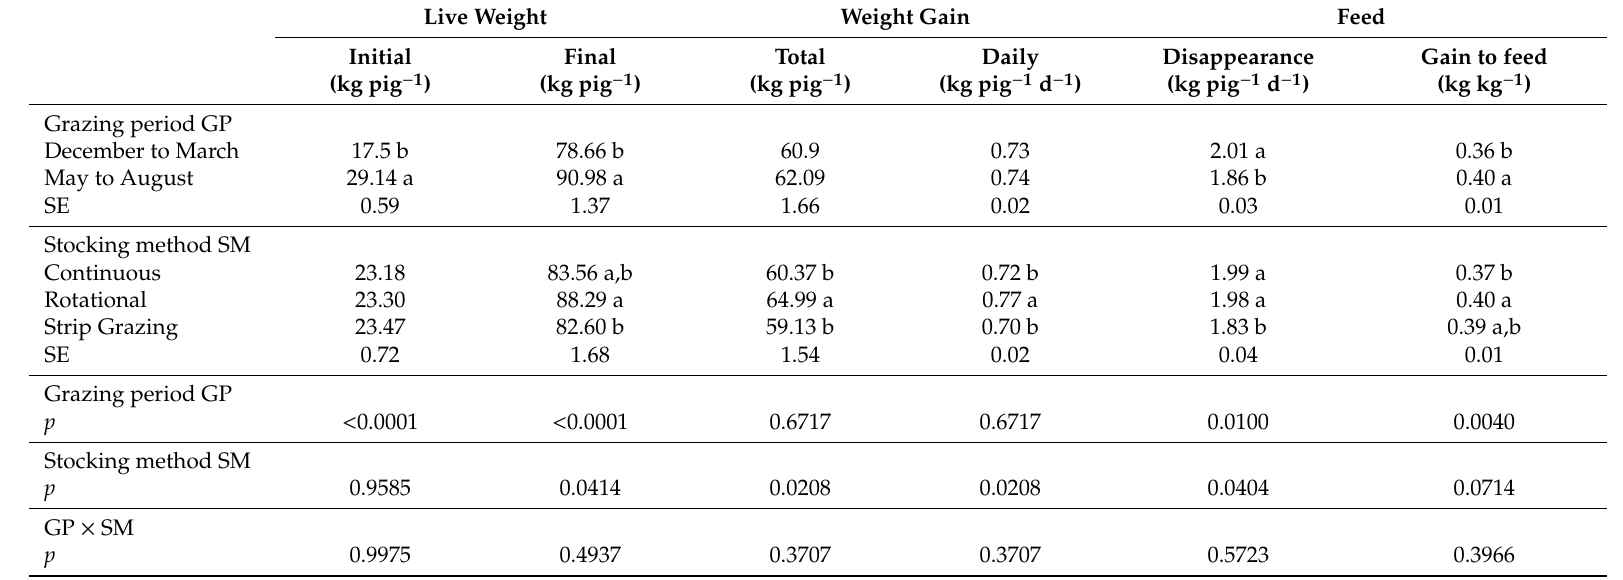
Table 5. E ff ect of stocking method on performance of growing-finishing pigs reared in tall fescue paddocks. Live Weight Weight Gain Feed Initial Final Total Daily Disappearance Gain to